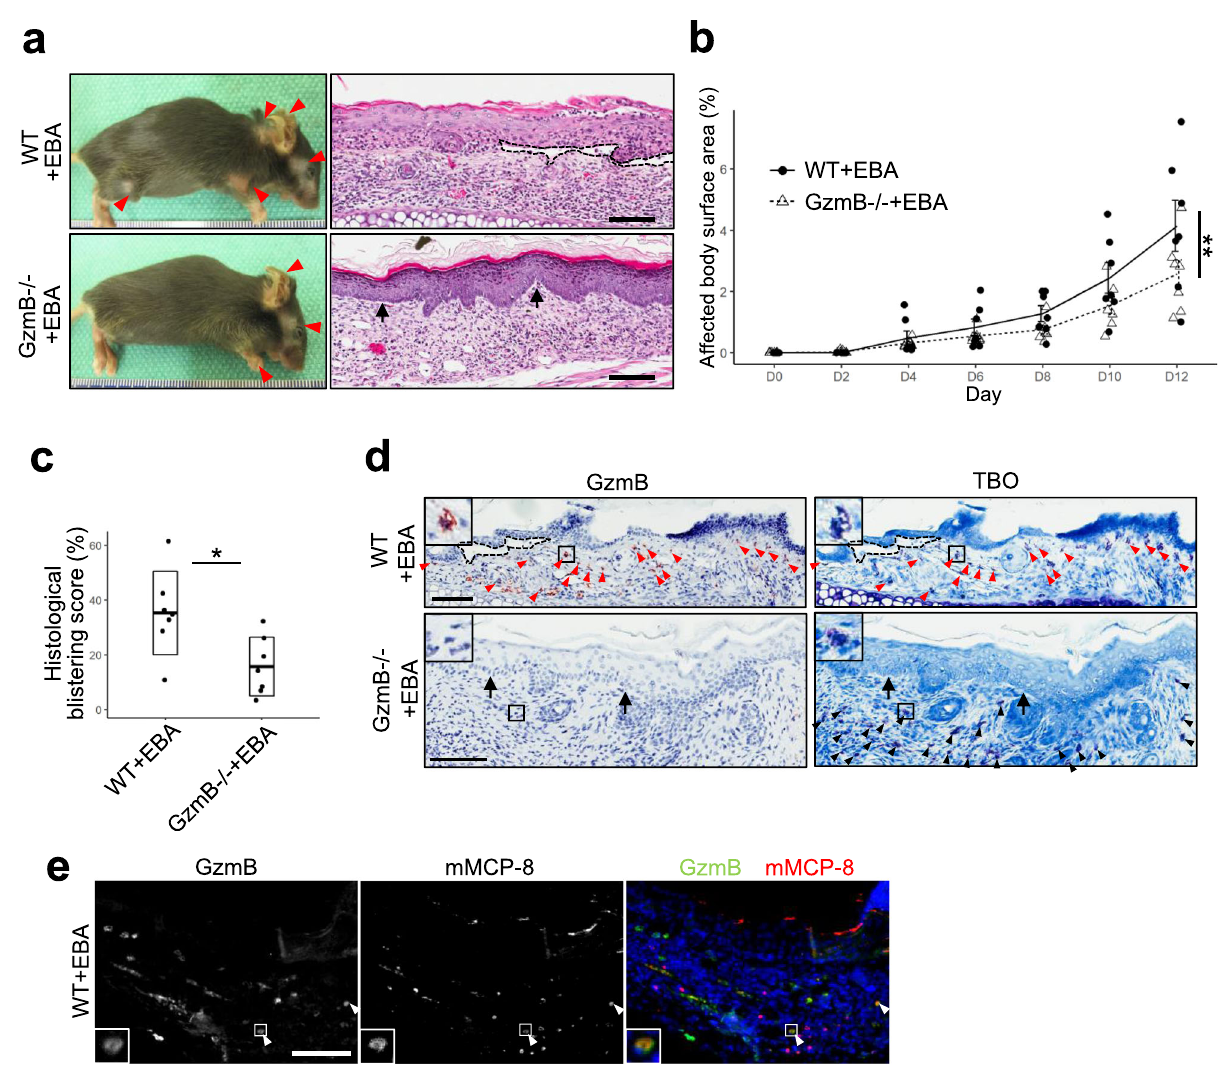
Fig. 1 Granzyme B (GzmB) − / − murine model of in fl ammatory epidermolysis bullosa acquisita (EBA) exhibits reduced blistering. a Representative clinical and H&E staining images of wild-type (WT) and GzmB − / − mice with EBA at day 12 induced by intraperitoneal injections of pathogenic anti-type VII collagen (COL7)-IgG, labeled as WT + EBA and GzmB − / − + EBA in the fi gures, respectively. Red arrowheads indicate clinical lesions. Dotted line demarcates major dermal – epidermal separation and black arrows indicate minor dermal – epidermal separation. Scale bar, 100 μ m. b Affected body surface area de fi ned as (total affected body surface area)/(total body surface area) × 100 was quanti fi ed every 2 days for 12 days. Dot plots indicate all individual scores and mean ± standard error. N = 7 for each strain. ** P < 0.01 (two-way ANOVA (time and strain as two variables)). c Histological blistering scores de fi ned as (combined total length of all blistered regions)/(combined total length of all dermal – epidermal junction examined) were quanti fi ed from H&E staining images at day 12. Dot plots indicate all individual scores and box plots indicate mean ± standard deviation. N = 7 for each strain. * P < 0.05 (two- sided Student ’ s t -test). d Representative sequential GzmB immunohistochemistry (IHC) and toluidine blue O (TBO) staining images of ears from WT and GzmB − / − mice with EBA at day 12. TBO stains mast cells and basophils dark blue to purple. Red arrowheads indicate cells stained with both GzmB and TBO. Black arrowheads indicate cells stained with TBO but not GzmB. Dotted line demarcates major dermal – epidermal separation and black arrows indicate minor dermal – epidermal separation. Scale bar, 100 μ m. e Representative double staining images of ears from WT mice with EBA at day 12 with antibodies against GzmB and mouse basophil marker mouse mast cell protease-8 (mMCP-8). Third column shows overlays of two stains. White arrowheads indicate cells stained with both GzmB and mMCP-8. Scale bar, 100 μ m. Images in a , d , and e are representative of two ( a ) or three ( d , e ) independent